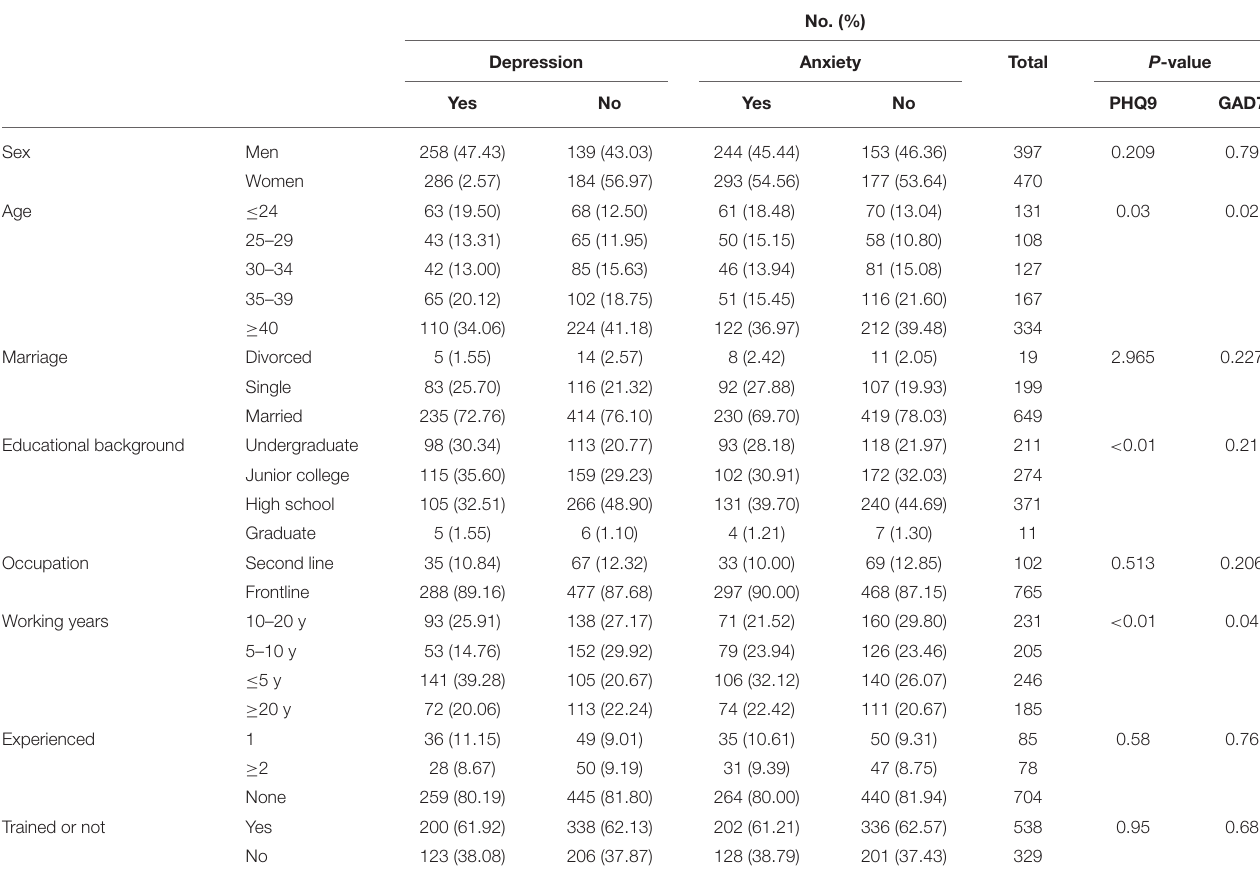
TABLE 1 | Sociodemographic and psychological characteristics of the study